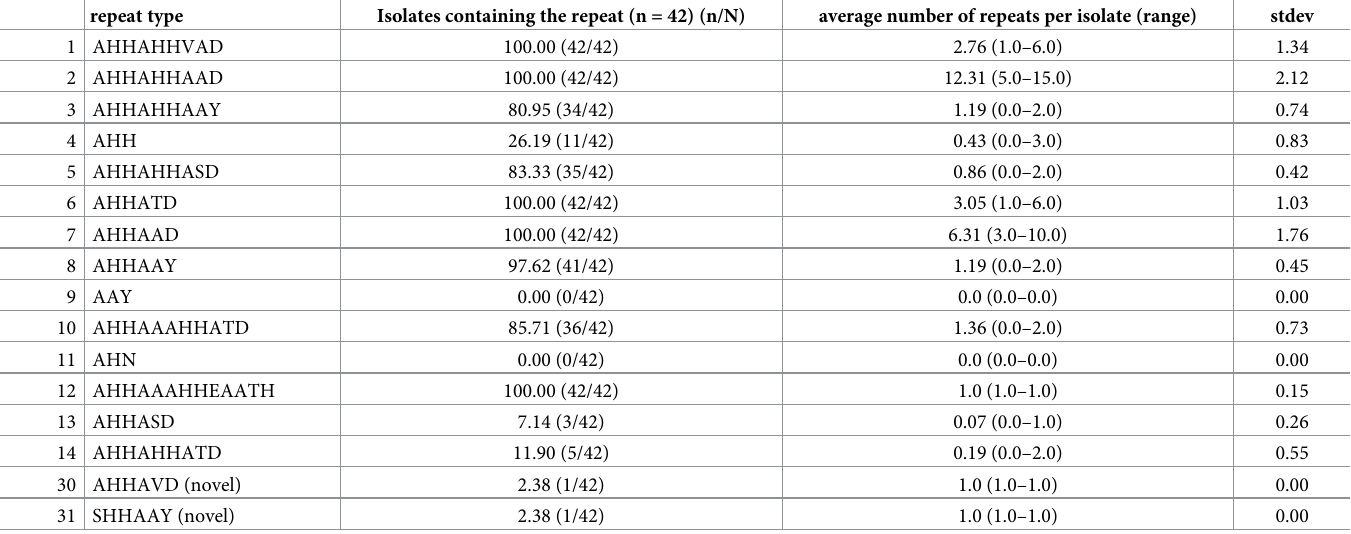
Table 6. Amino acid repeat composition of analyzed